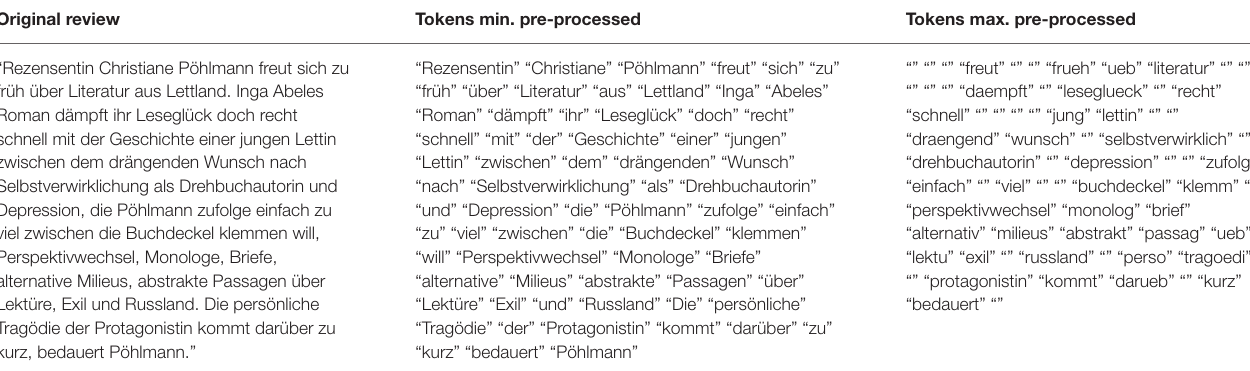
TABLE 2 | Illustration of minimal vs. maximal pre-processing on an examplary